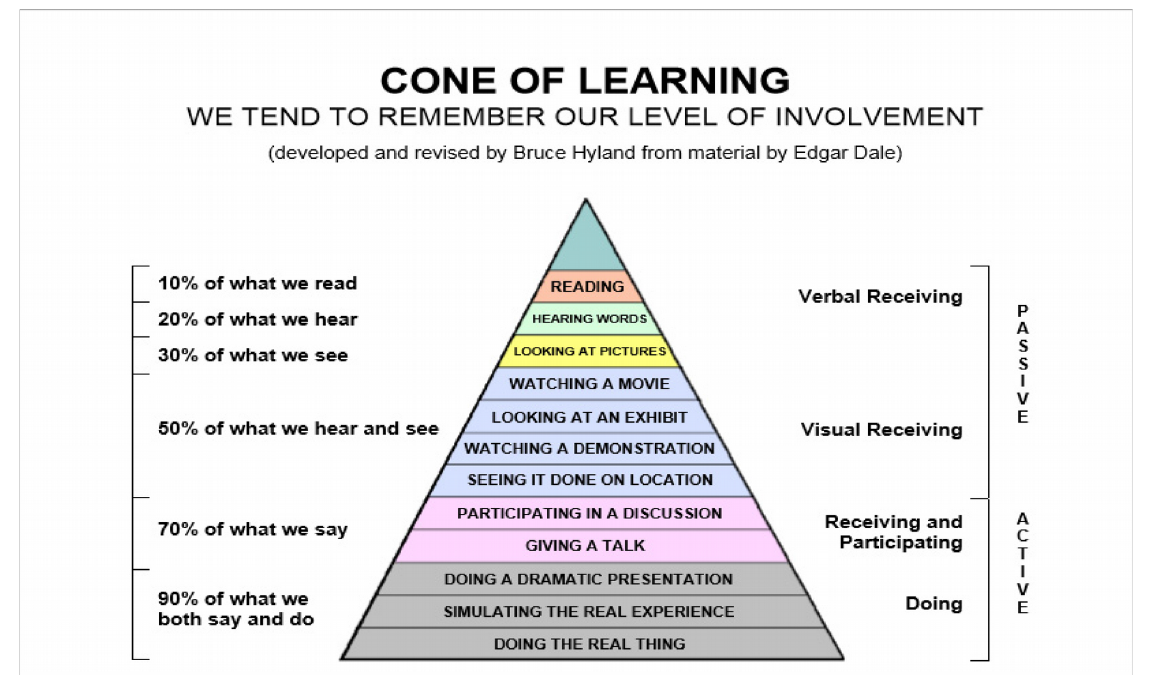
Figure 2. Dale’s Cone of Learning